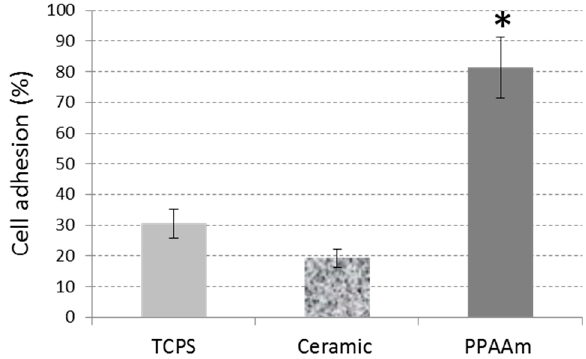
Figure 12. Initial cell adhesion (10 min) on plasma polymer modified smooth ceramic (PPAAm, 960 s gross). Flow cytometry, Student’s t -test: PPAAm vs. bare ceramic (no. BK034) * p < 0.01, PPAAm vs. tissue culture plastic (TCPS) * p < 0.05; mean ± s.e.m., n = 3 independent experiments.